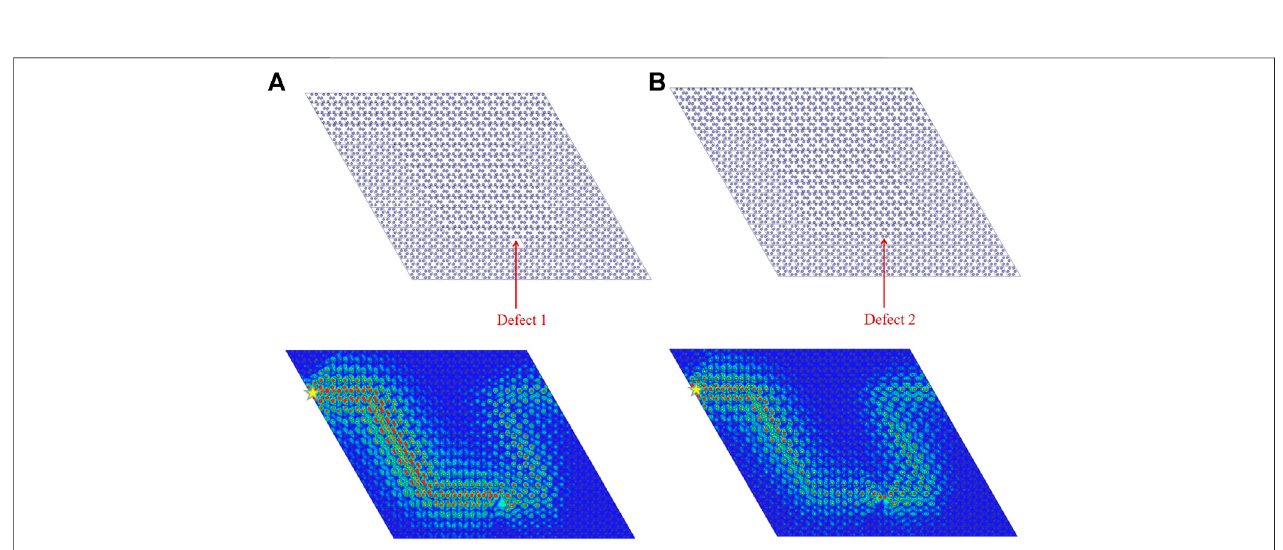
FIGURE 5 | Two types of the defects and the corresponding electric fi eld distributions at 5.7 GHz. (A) Defect 1, and (B) Defect